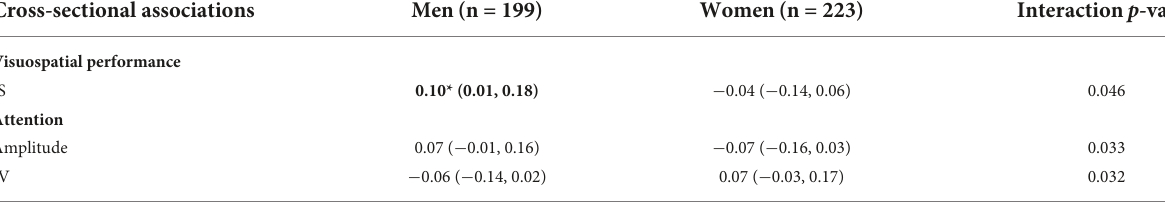
TABLE 12 Sex: significant cross-sectional interactions with CRARs on cognition, estimated beta (95% CI). Cross-sectional